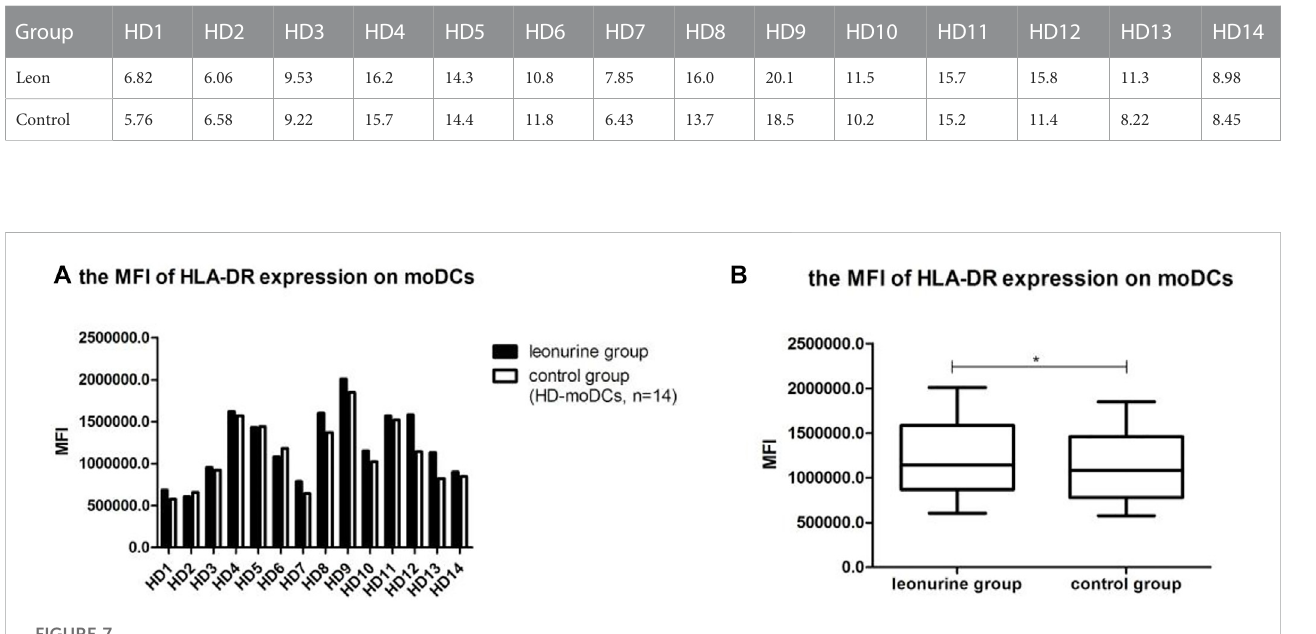
TABLE 5 The MFI of HLA-DR expression on moDCs (× 105) (HD-moDCs, n = 14).